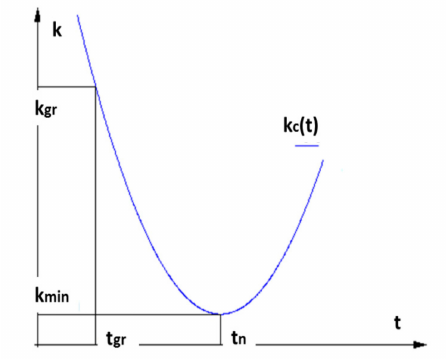
Figure 1. Dependence of the costs of the undertaking on the time of its implementation